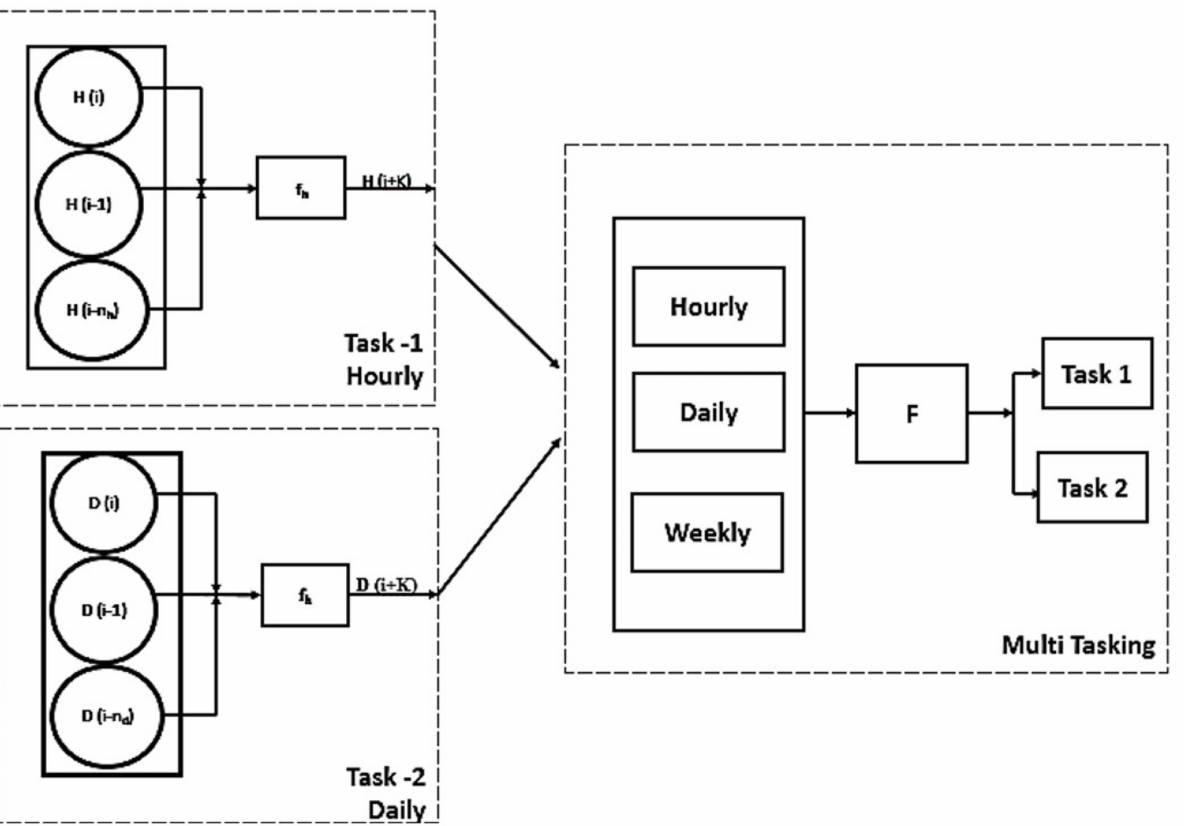
Figure 3. Multi-tasking